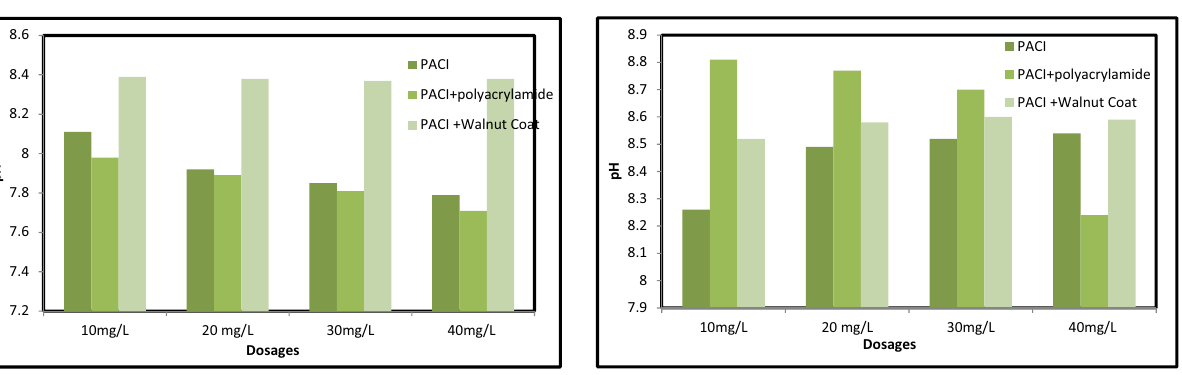
Figure 10: The relation between pH and dosages of coagulant and its aids for samples at 180 cm